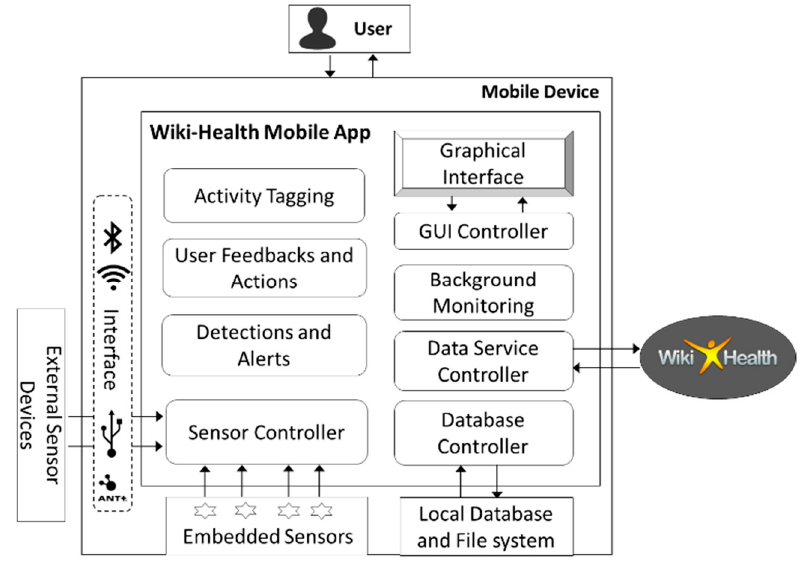
Figure 3. Architecture of the Wiki-Health Mobile App.